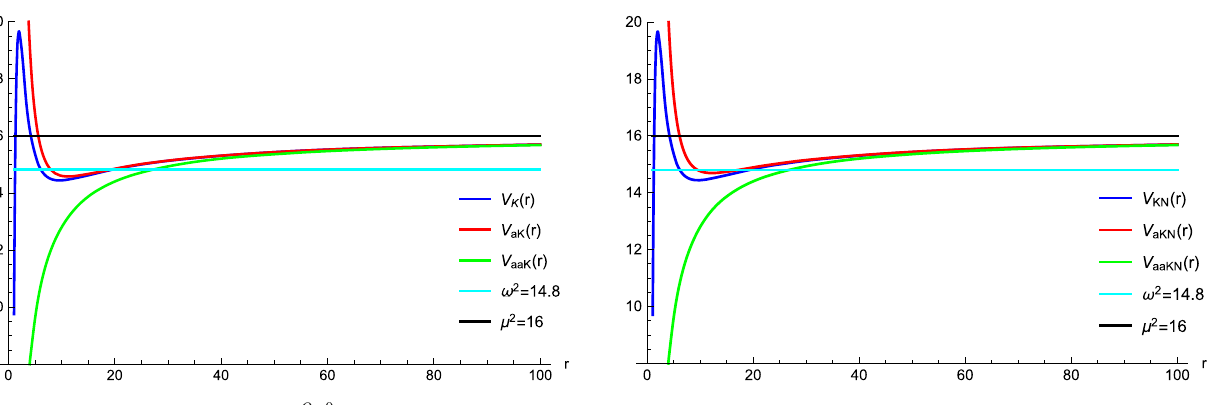
( r ) and its asymptotic poten- Fig. 4 Positive potential V K ( r ) = V Q = 0 Fig. 6 Positivepotential V KN ( r ) anditsasymptoticpotential V aKN ( r ) KN = 0 as functions of r ∈ [ r + = 1 . 062 , 100 ] with M = 1 , Q = 0 . 01 ,ω = ( r ) around Kerr background as function of r ∈ tial V aK ( r ) = V Q aKN 3 . 85 , a = 0 . 998 , m = 13 , q = 0 . 2 ,λ lm = 180 ,μ = 4. V KN ( r ) is [ r + = 1 . 063 , 100 ] with M = 1 , Q = 0 ,ω = 3 . 85 , a = 0 . 998 , m = finite (9.728) at r = r + and it has a trapping well located at r = 9 . 61. 13 , q = 0 ,λ lm = 180 ,μ = 4. The potential is finite (9.754) at r = r + Also, V aKN ( r ) imitates V KN ( r ) well for r ≥ 20 whereas V aaKN ( r ) and it has a trapping well (local minimum) at r = 9 . 6. V aK ( r ) mimics mimics V KN ( r ) for r ≥ 50. We note ω < ω c = 5 . 6398 and ω < μ V K ( r ) well for r ≥ 20, while V aaK ( r ) mimics V K ( r ) for r ≥ 50